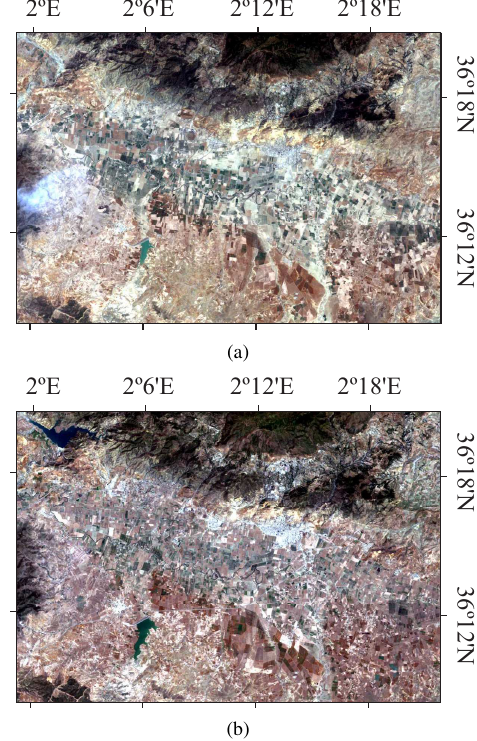
Figure 2: The studied area of Algeria: image acquired on